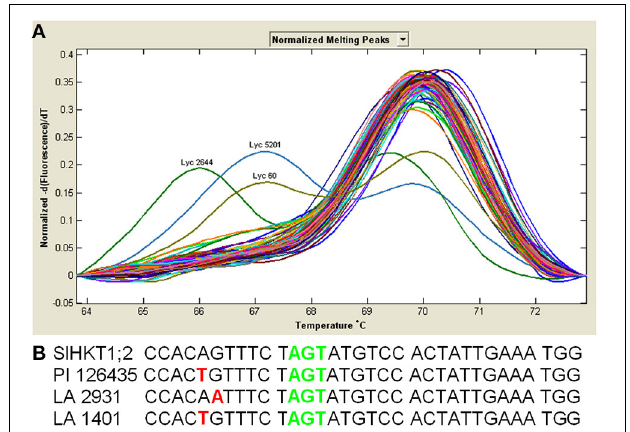
FIGURE 1 | Tomato accessions show SNPs close to the S at the filter position of the first pore domain, but not in the nucleotides coding the S residue. (A) Solanum HKT1;2 melting curve derivative plots from 93 tomato accessions showing the two different SNP’s identified close to the 1st pore domain. (B) Nucleotide sequences of the HKT1;2 gene of different Solanum accessions show that both SNPs (red letters) situate close to, but do not coincide with the S70 residue of the first pore domain (green letters). Black colored letters represent conserved